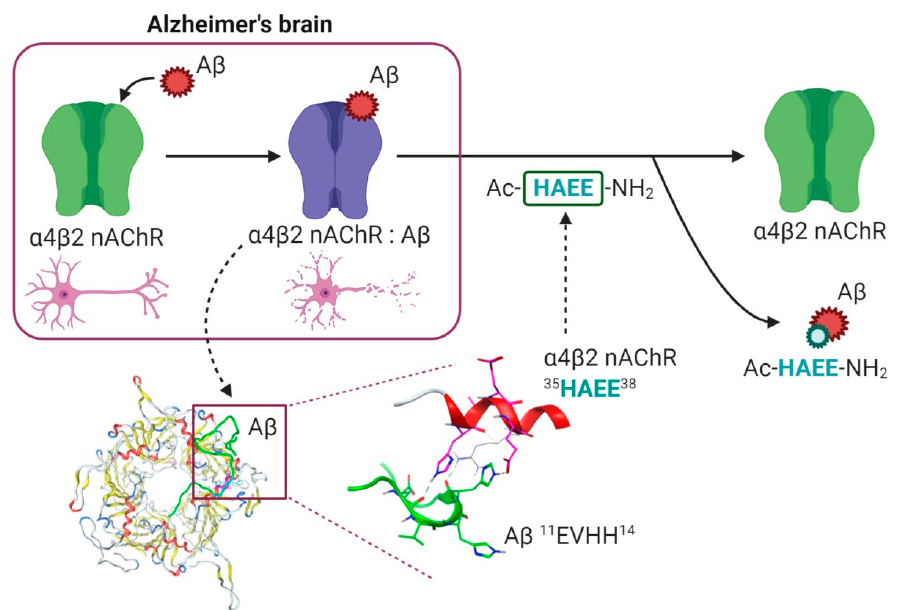
Figure 6. The possible role of 11 EVHH 14 : 35 HAEE 38 interface in cholinergic deficit associated with Alzheimer’s disease. In brains of Alzheimer’s disease patients, interaction of A β with nAChRs causes transition of the receptor from functional state (green) to dysfunctional state (violet), which may lead to selective loss of cholinergic neurons (top left). Our results suggest that the interaction of A β with α 4 β 2 nAChR is mediated by charge complementary interface 11 EVHH 14 : 35 HAEE 38 (bottom left and middle) and that Ac-HAEE-NH 2 peptide corresponding to this interface can competitively displace A β from the complex and restore the functionality of α 4 β 2 nAChR (top right).